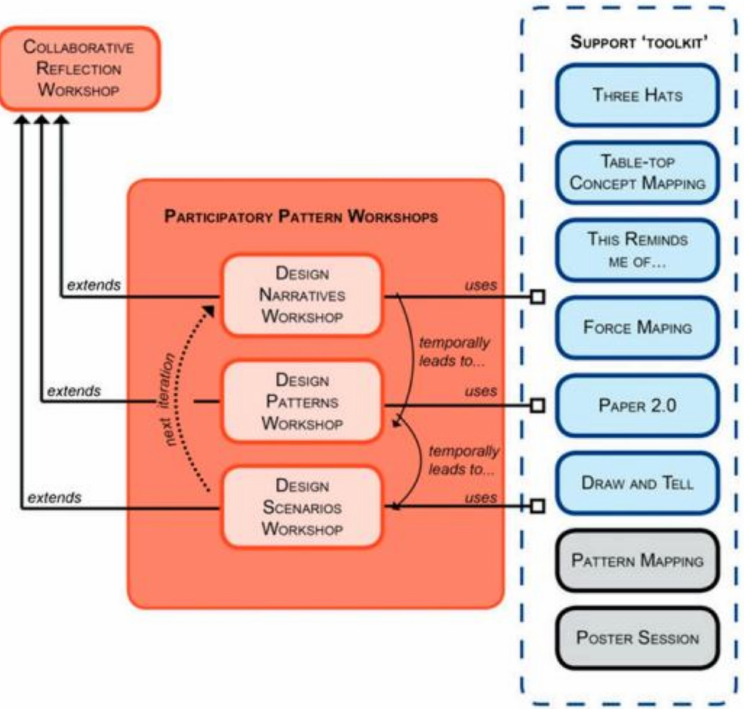
Figure 1. SNaP method! (scenarios, narratives, and patterns) in the format of participatory patterns workshops